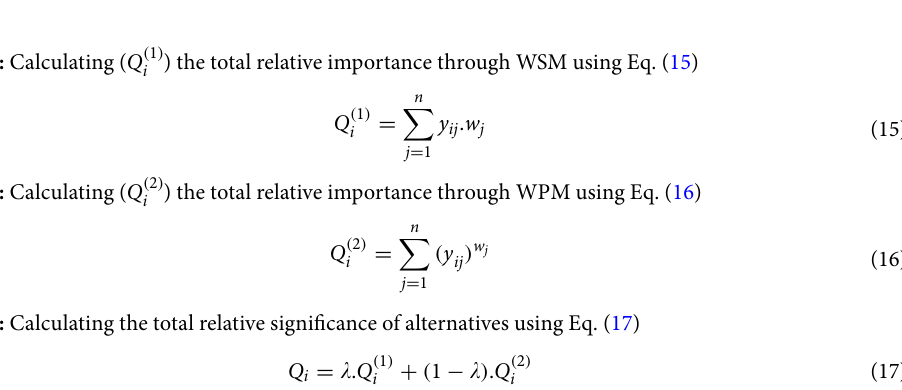
Table 8. PSO results versus experiment